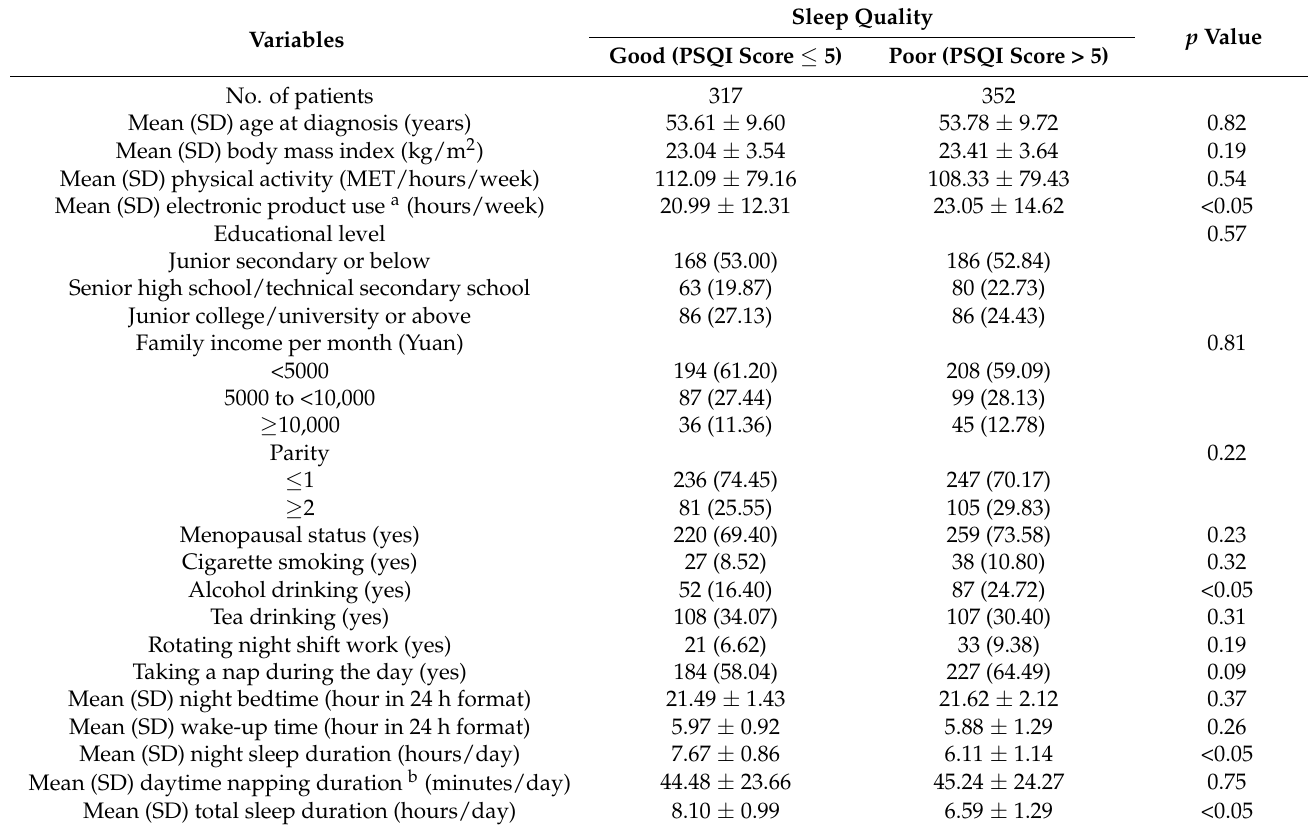
Table 1. General characteristics of ovarian cancer patients according to sleep quality (N = 669). Values are numbers (percentages) unless stating otherwise.